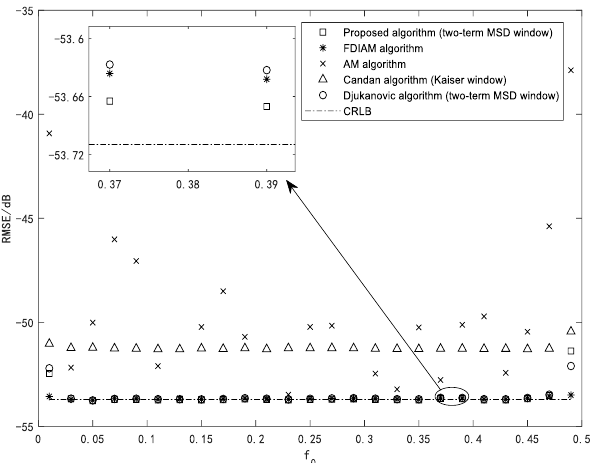
= 256, φ = π /8, and SNR = 30 Figure 3. RMSEs versus 0 f for Figure 3. RMSEs versus f 0 for N